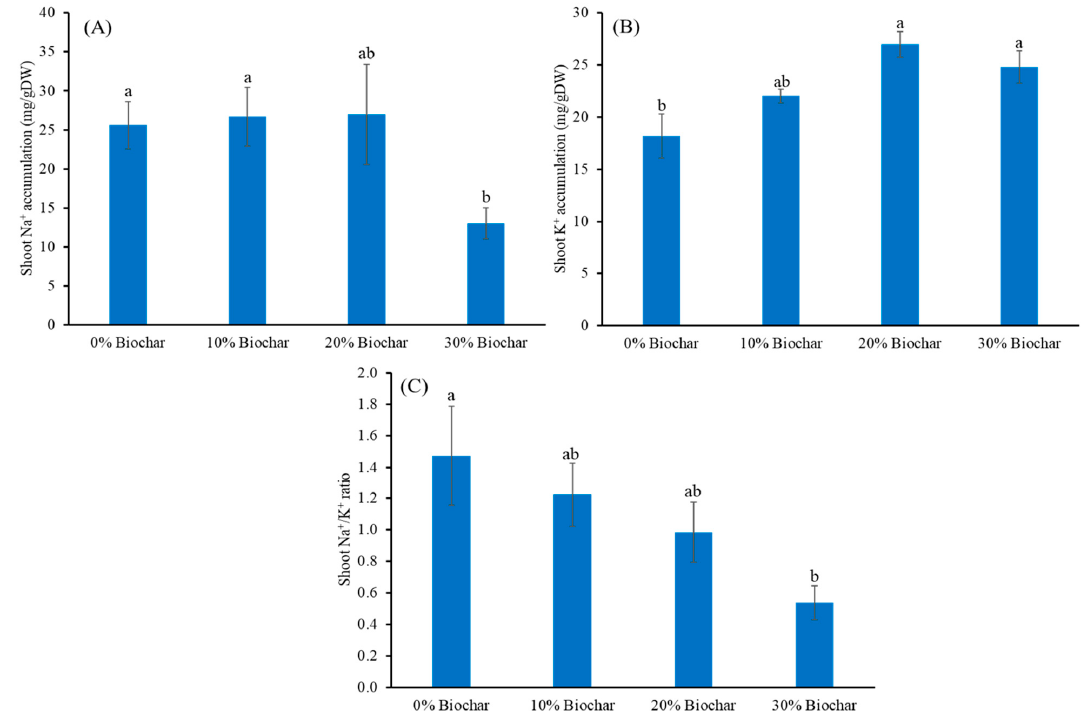
Figure 2. Shoot Na+ concentrations ( A ), shoot K+ concentrations ( B ), and shoot Na+/K+ ratios ( C ) for Phitsanulok 2 rice grown in saline soil with saltwater intrusion and different rates of biochar application. Data are means ± SE (n = 3). Bars with different letters are significantly different at p < 0.05 according to DMRT.